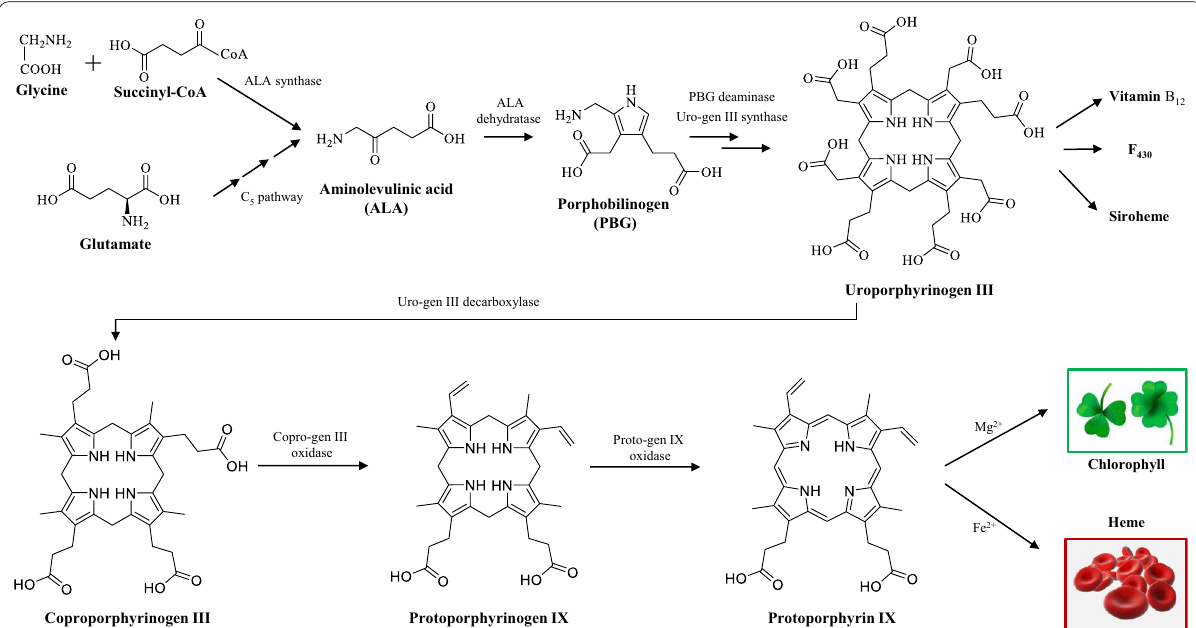
Fig. 7 Schematic for the biosynthetic pathways of tetrapyrroles. Tetrapyrroles, including vitamin B 12 , F 430 , siroheme, chlorophyll and heme, are initiated from condensation of glycine and succinyl-CoA or synthesized through C 5 pathway from the C 5 -skeleton of